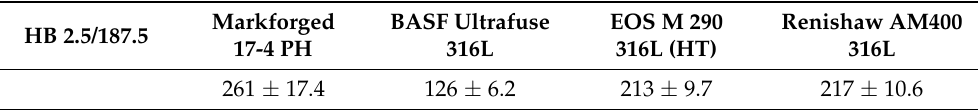
Table 8. Average and standard deviation (mean ± standard deviation) of the hardness of fatigue specimens close to fractures.